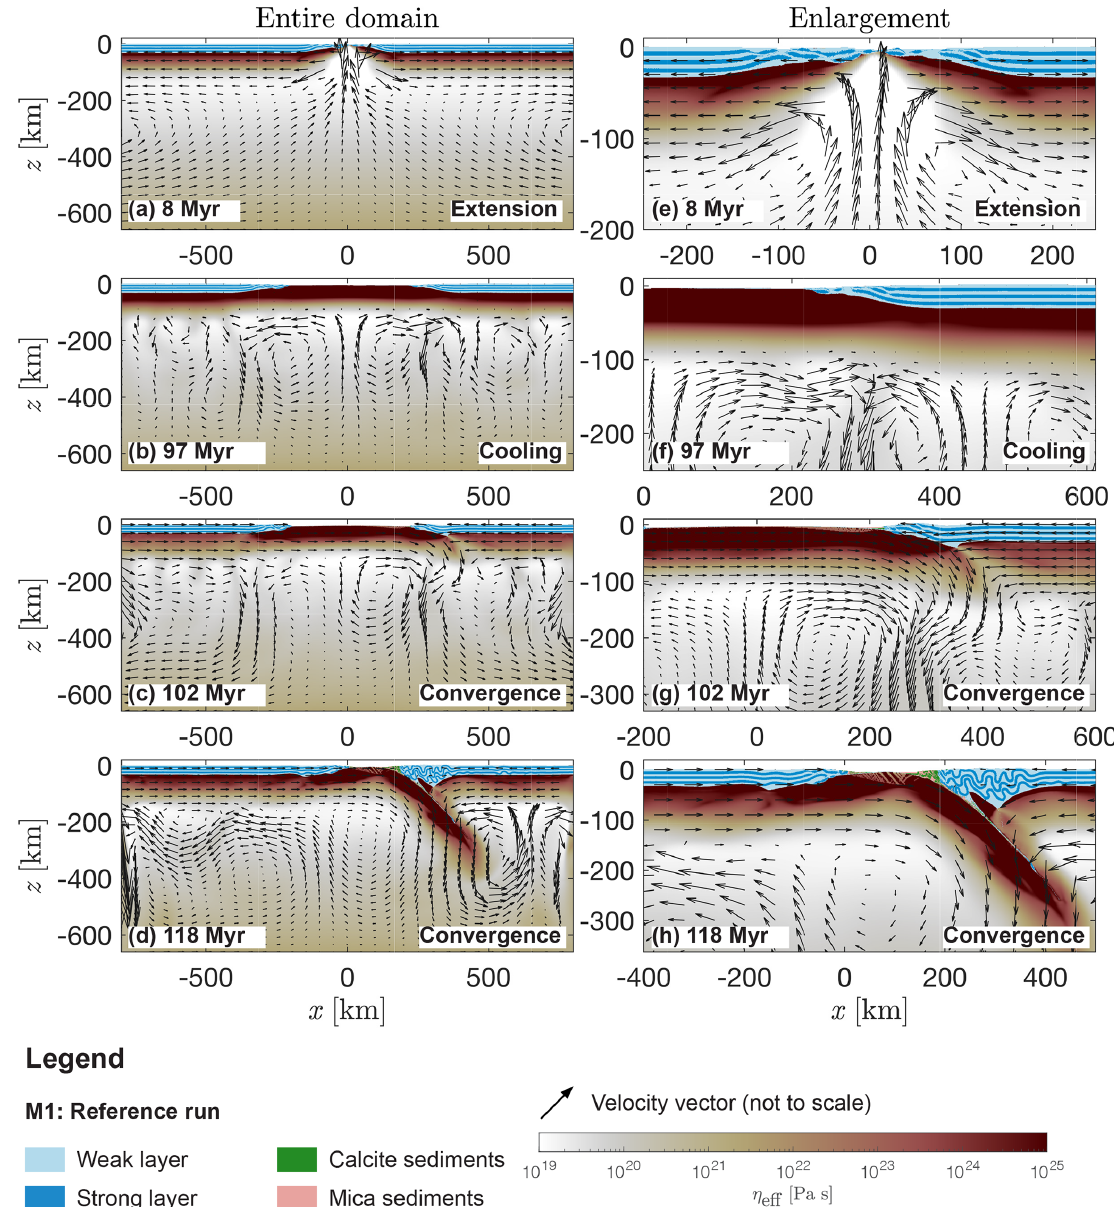
Figure 3. Model evolution of M1 (reference run). (a, b, c, d) Entire domain. (e, f, g, h) Enlargement. Dark and light blue colours indicate the material phase of weak and strong layers of mica (salmon) and calcite (green) sediments, respectively. White to red colours indicate the effective viscosity field calculated by the algorithm. Arrows represent velocity vectors, and the length of the arrows is not to scale. Scientific colour maps used in all figures are provided by Crameri